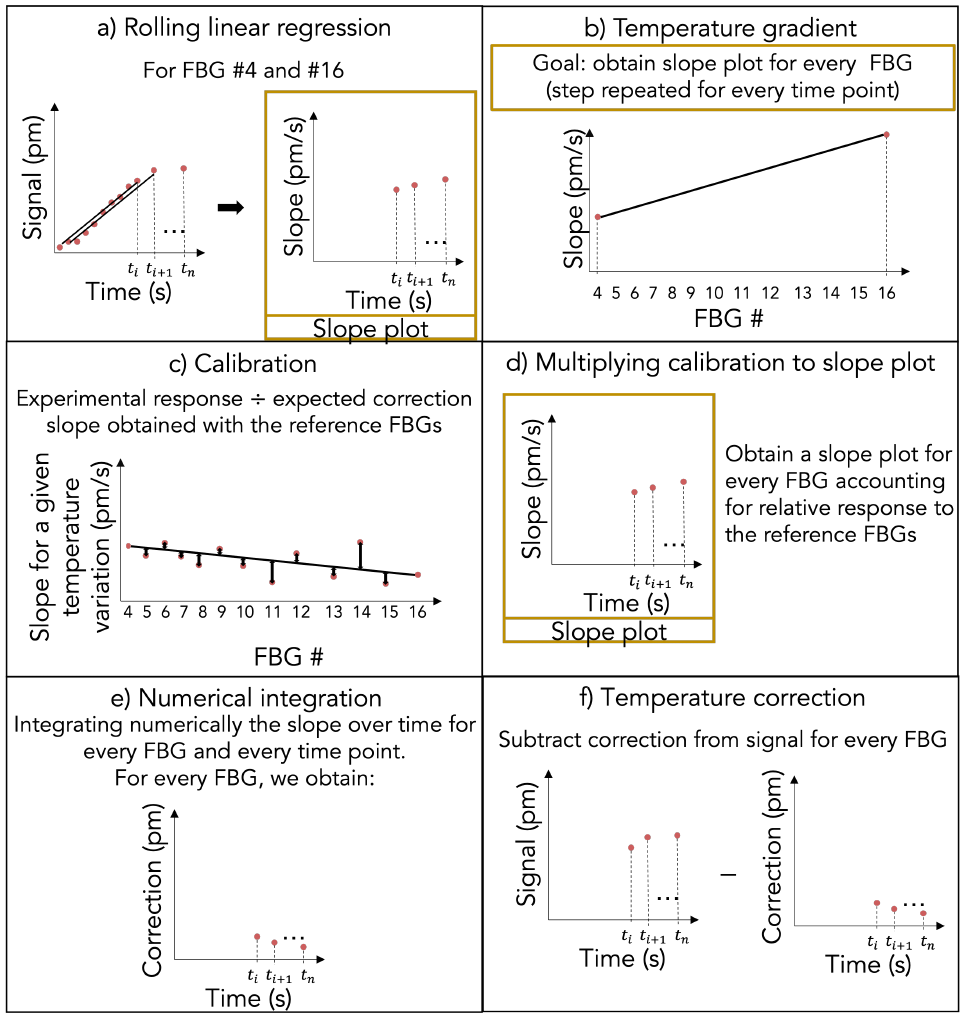
Figure 2. Steps to apply ITG technique: ( a ) apply a rolling linear regression to the raw data; ( b ) calcu- late the temperature gradient for each FBG at every time point (at the end of this step, the slope for temperature variation in time for every FBGs, called the slope plots, is obtained); ( c ) calculate the calibration factor for every FBG relative to the reference FBGs; ( d ) multiplying calibration to slope plots; ( e ) apply a numerical integration of the slope plots for every FBGs and every time point and ( f ) apply the temperature correction by subtracting the correction for the temperature contribution obtained in ( e ) to the raw